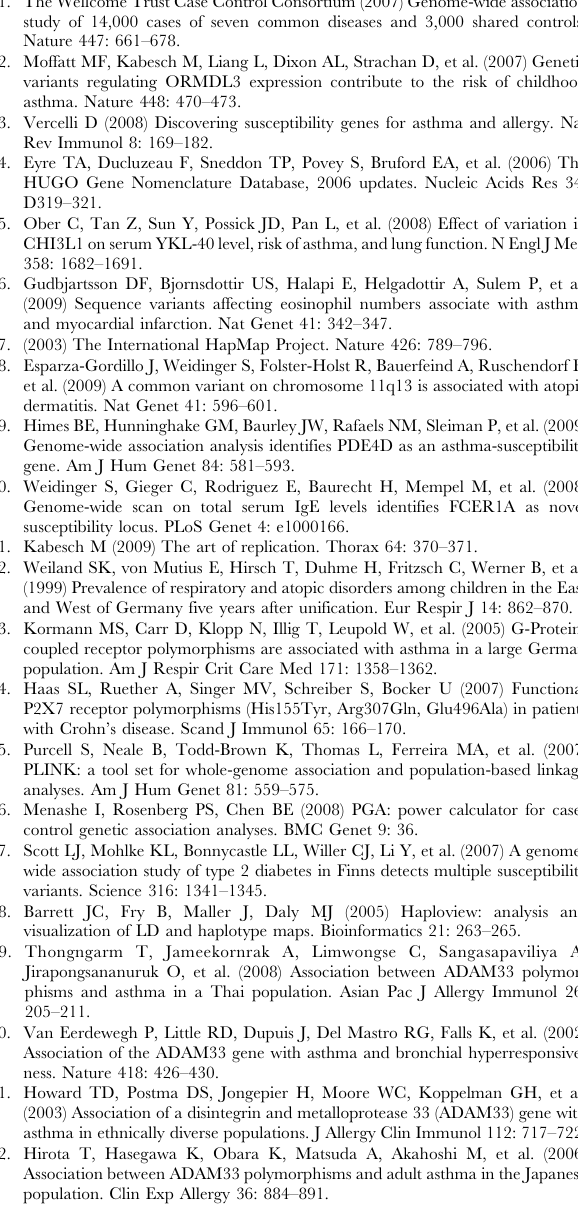
Table S2 Candidate gene associations with asthma and comparison between genotyping and imputation results. Odds ratios, 95% confidence intervals are given for SNP effects. R2 is given for SNPs were both imputation and genotyping data is available. Bold font indicates previously reported SNPs, standard font is tagging SNPs, cursive font indicates SNPs that are neither tagging nor previously reported SNPs; * p , 0.05; **p , 0.0035